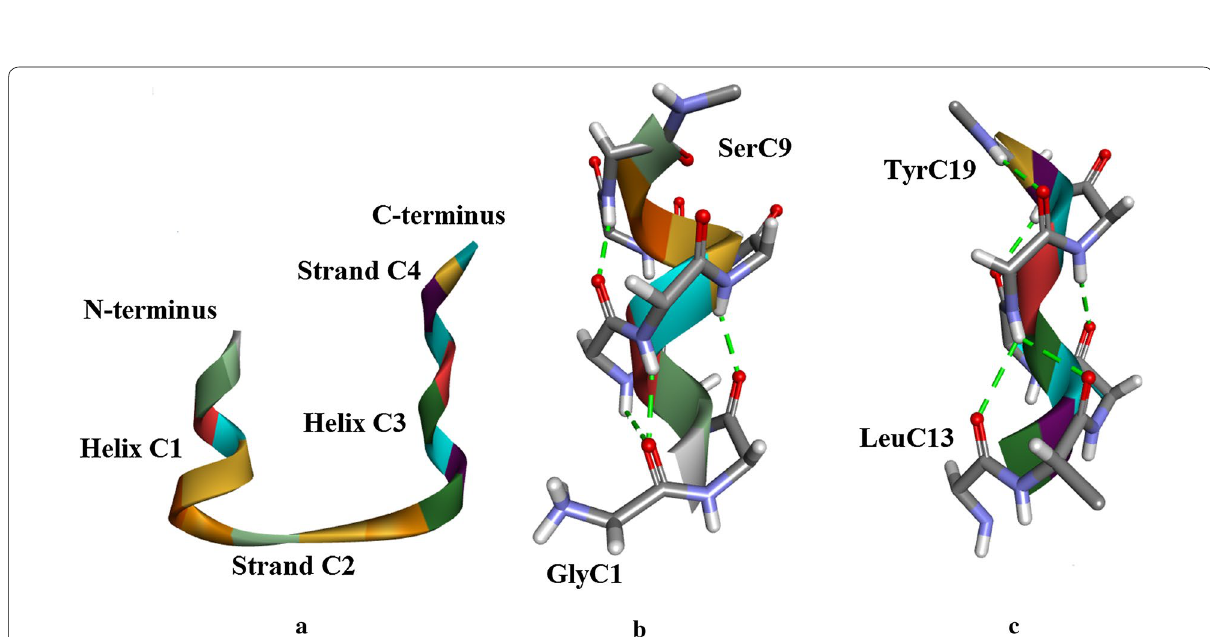
Fig. 5 a Insugen (I) chain C: secondary structure motifs (compare with Fig. 4a for chain A). b Insugen (I) Helix C1: GlyC1–SerC9. H‑bonds are shown as green dashed lines . Main chain atoms only are shown. Compare with Figure S9b which shows the same region in porcine insulin [1]. c Insugen (I) chain C Helix C3: LeuC13–TyrC19. H‑bonds are shown as green dashed lines . Main chain atoms only are shown. Drawn with Biovia, Discovery Studio 2016